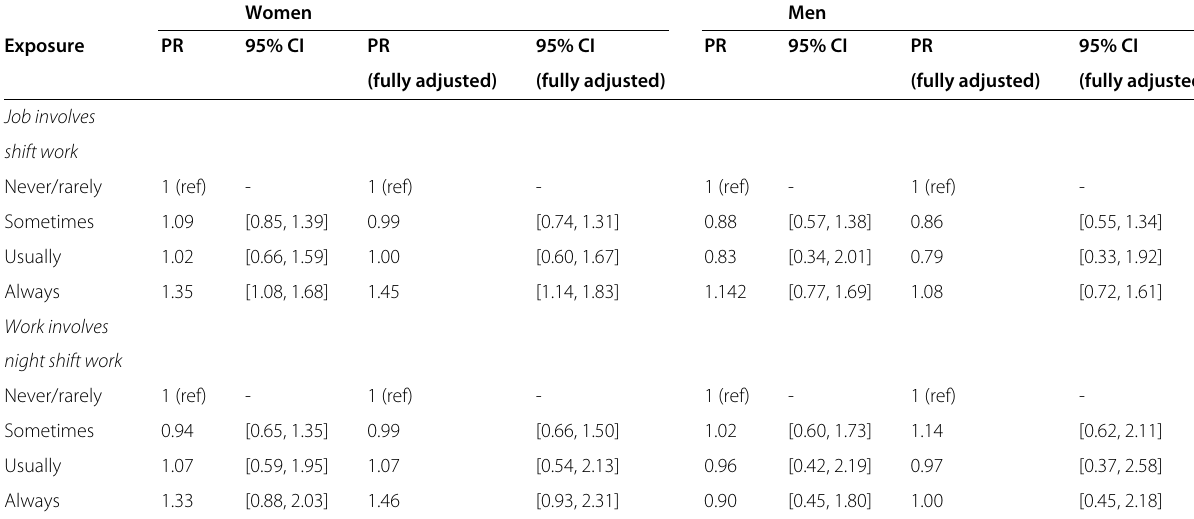
Table 5 Prevalence of migraineurs among different job-related categories (shift work)